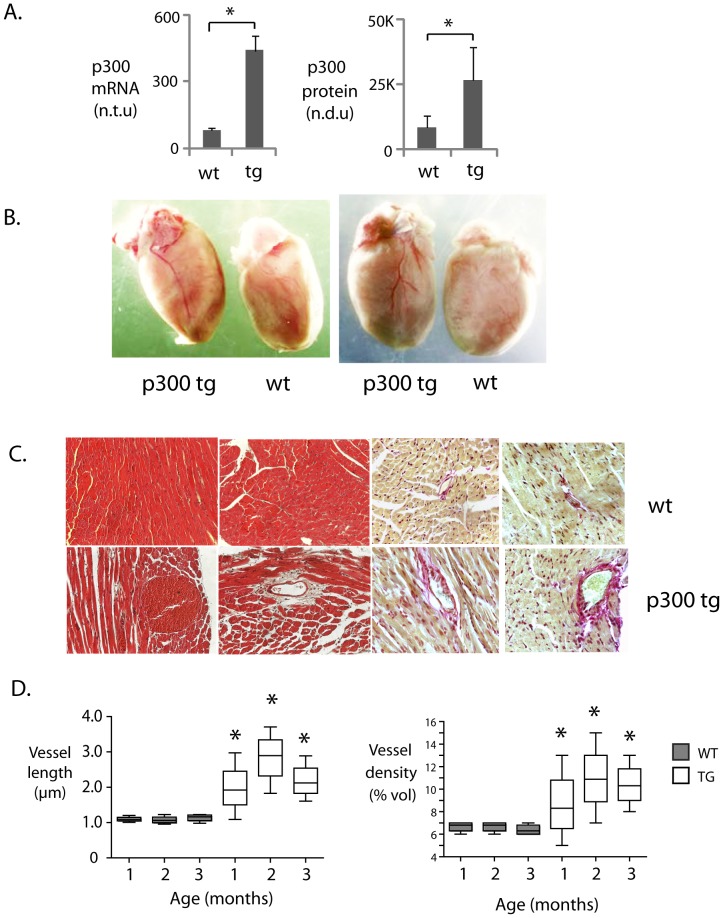
Cardiac-specific overexpression of p300 induces compensatory blood vessel growth. A. Alpha-MHC promoter-driven transgenic upregulation of p300.p300 mRNA and protein are upregulated at 1 month of age in p300tg relative to wt left ventricular muscle (LV). n = 4 per group; * = p<0.05; n.t.u = normalized transcript units; n.d.u = normalized densitometry units. B. Enlargement of epicardial coronary vessels in p300 tg hearts. Anterior (left) and posterior (right) views of p300tg (TG) and wild type (WT) littermate hearts at 6 months of age. C. Increased blood vessel density in p300tg relative to WT myocardium. Hematoxylin and eosin staining (left) and picrosirius red (right) of myocardial tissue from 3 month wt (top row) and p300 tg (bottom row) littermate hearts. Picrosirius staining is shown in brightfield and epi fluorescence. Original magnification = 10x. D. Quantitatitve morphometry of images as in C. Left: median vessel length in wt (shaded) and tg (clear) at the indicated ages. Right: vessel density as a percentage of tissue volume (% vol). n = 5 per group, * = p<0.001 at all time points for comparison between wt and p300 tg mice.